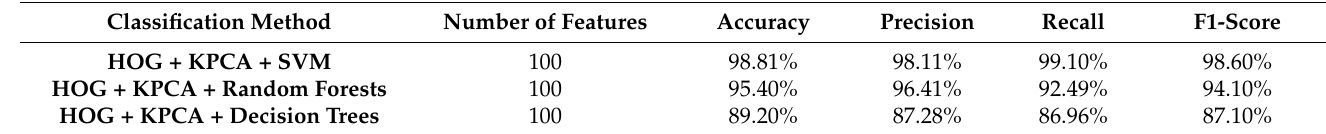
Table 3. Accuracy, Precision, Recall, and F1-scores using HOG features.